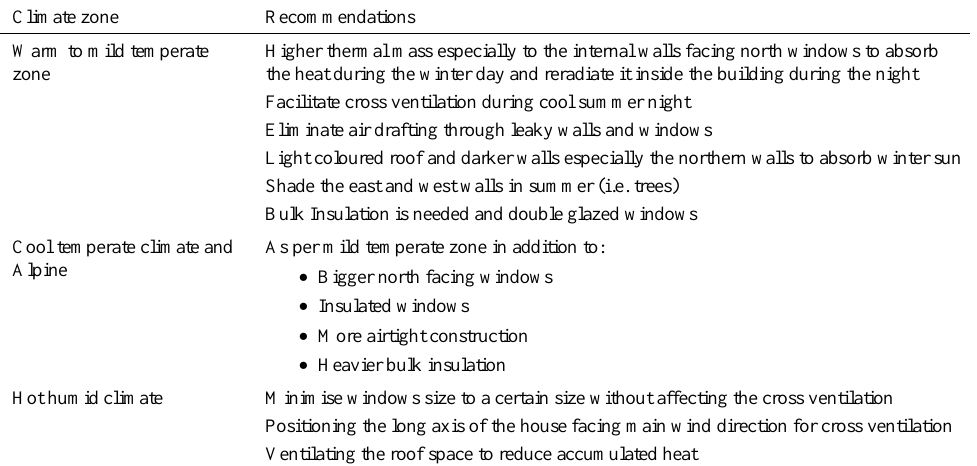
Table 4 summarises the recommendations to achieve higher star rating for InsCB Module in different climate